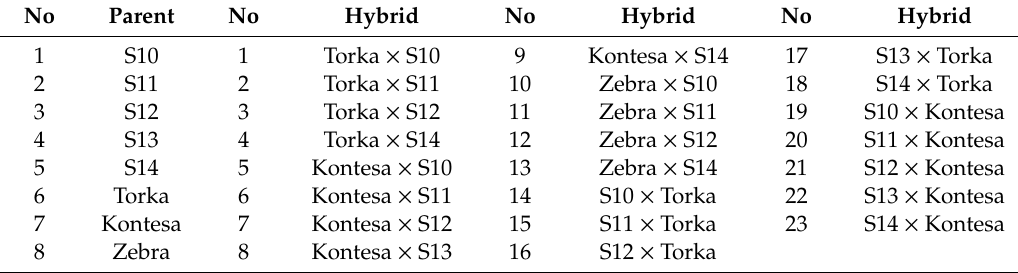
Table 1. Hybrids and their parental forms analyzed in the